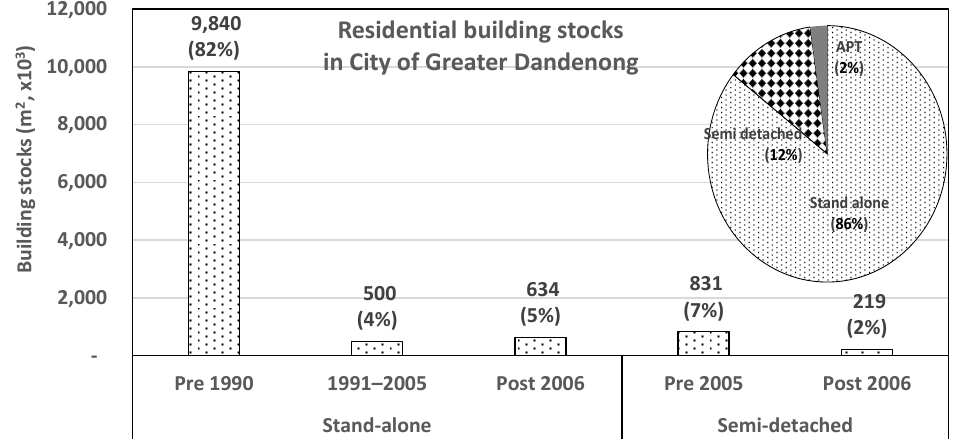
Figure 2 . Number of dwellings in the Greater Dandenong building stock [86] . Figure 2. Number of dwellings in the Greater Dandenong building stock [86]. Table 3. Categorised dwelling prototypes of the residential building